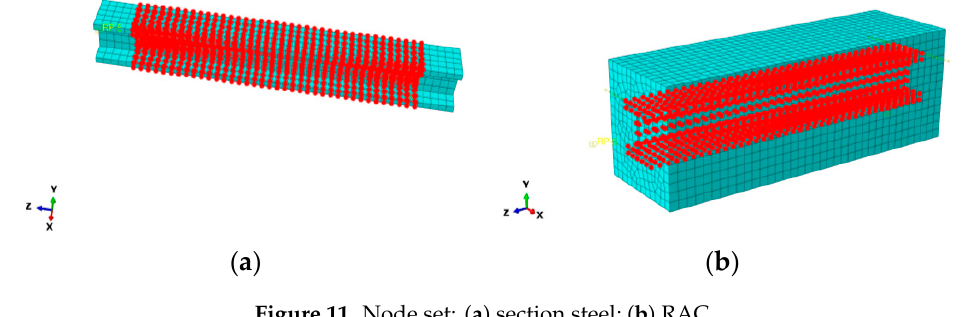
Figure 11. Node set: ( a ) section steel; ( b ) RAC .